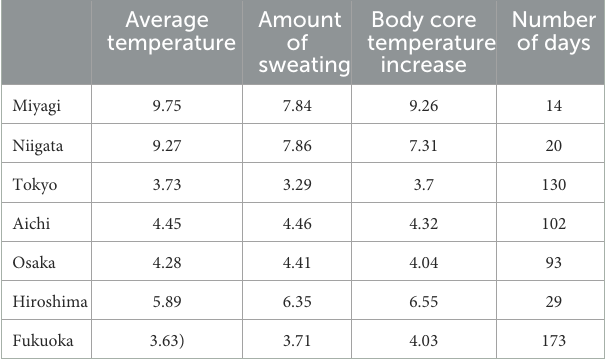
TABLE 5 Average MAEs per million population and number of days with WBGT ≥ 31 ◦ C for seven prefectures in Figure 6. Average Amount Body core Number temperature of temperature of sweating increase